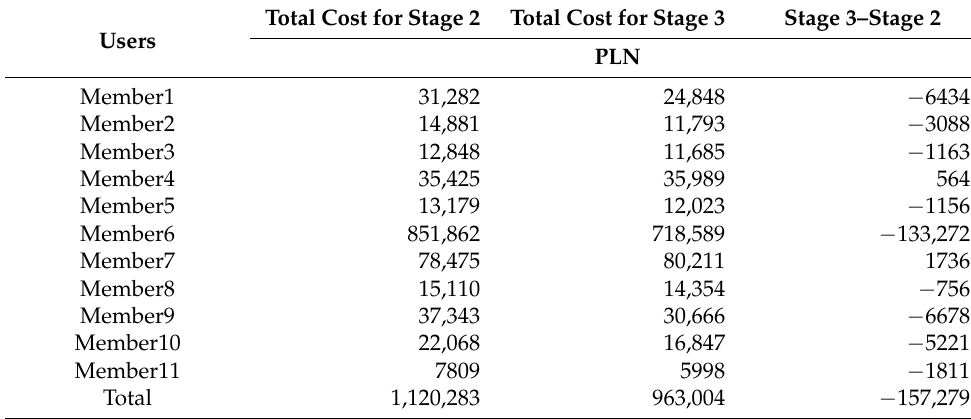
Table 6. Economic effect for an energy